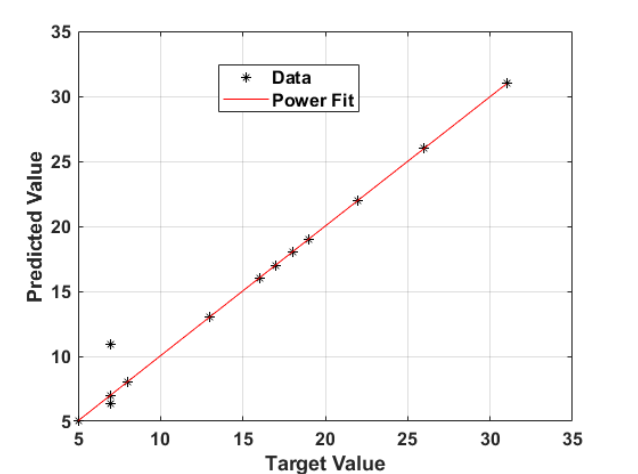
Figure 15. System failure plot of target vs. predicted value for ANN Model 1 training.